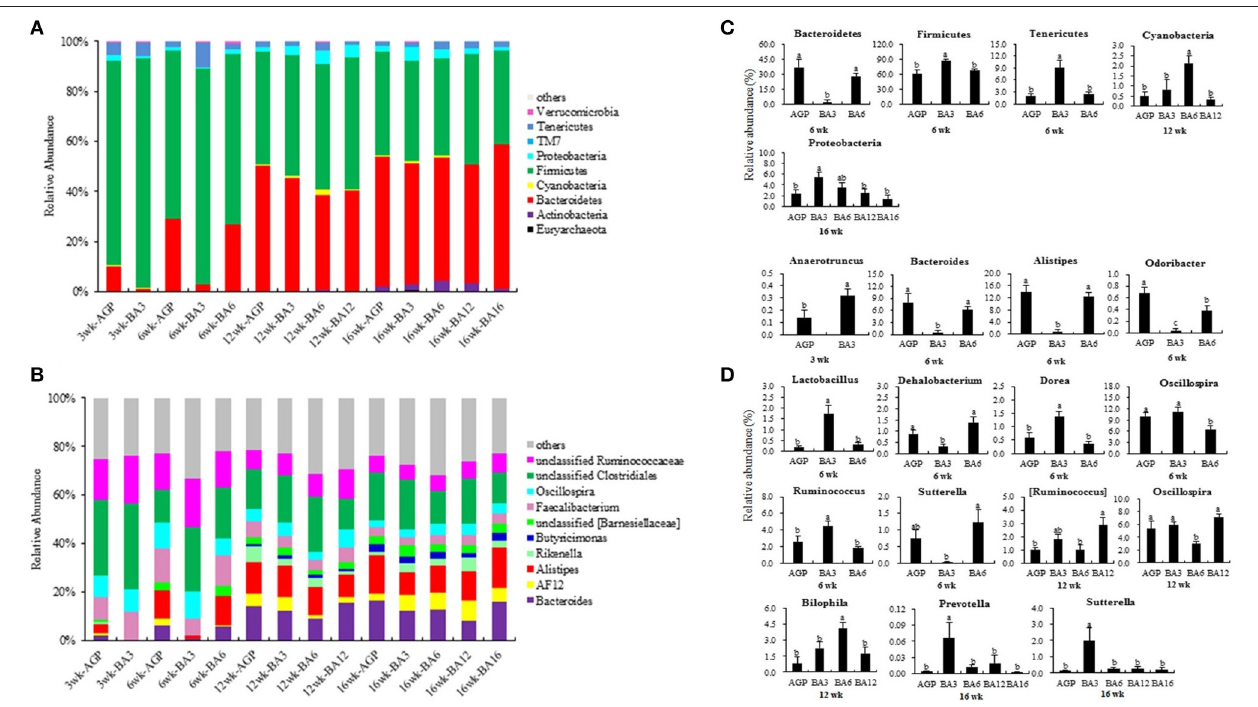
FIGURE 3 | Composition of the caecal microbiome of pullets from different groups. The caecal microbiota at phylum (A) and genus (B) levels, the differentially abundant phylum (C) and genera (D) in caecum of pullets from 0 to 16 weeks ( P < 0.05). For (A) and (B) , a color-coded bar plot shows the average bacterial phylum and genus distribution in different mixed groups and AGP group from 0 to 16